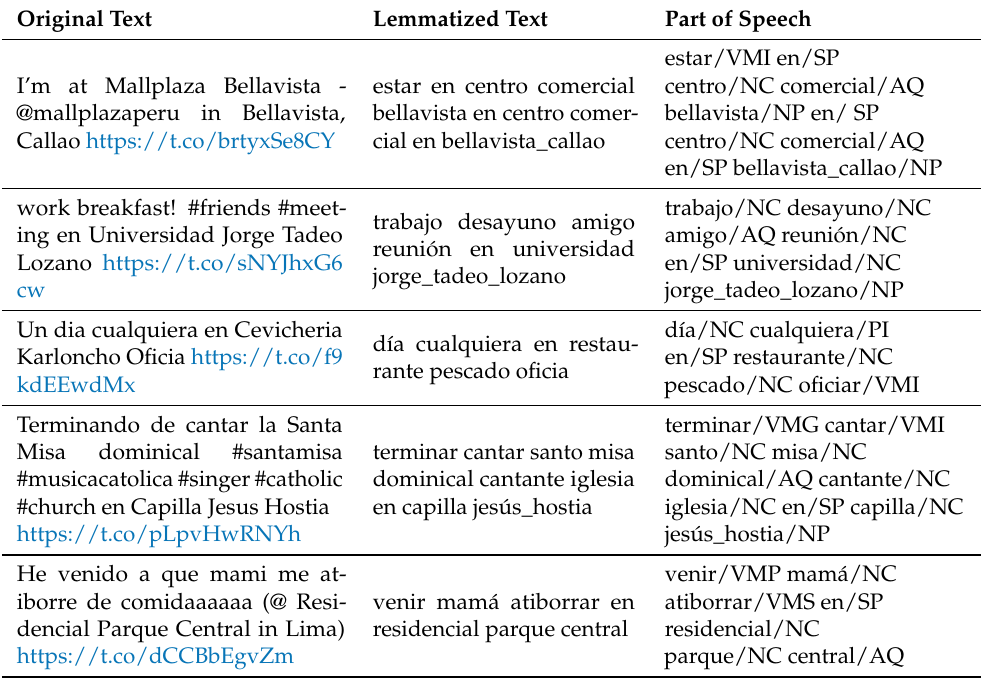
Table 6. Text output after lemmatization and PoS tag with